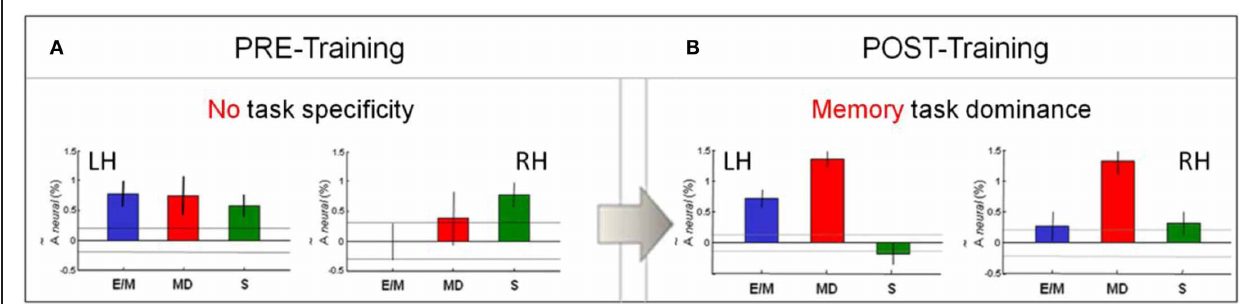
FIGURE 7 | Pre/post-training comparison of V1 activation pattern across the three tasks. (A) There was no task-specificity in V1 before training. (B) Remarkably, a clear specialization for MD (red) emerged after training. Bar-graphs show the estimated activation in each hemisphere for each task— E/M , MD , S . The activation levels refer to the beta weights for the event types in the GLM. The dashed lines and the error bars represent confidence intervals for two different forms of statistical comparison of the